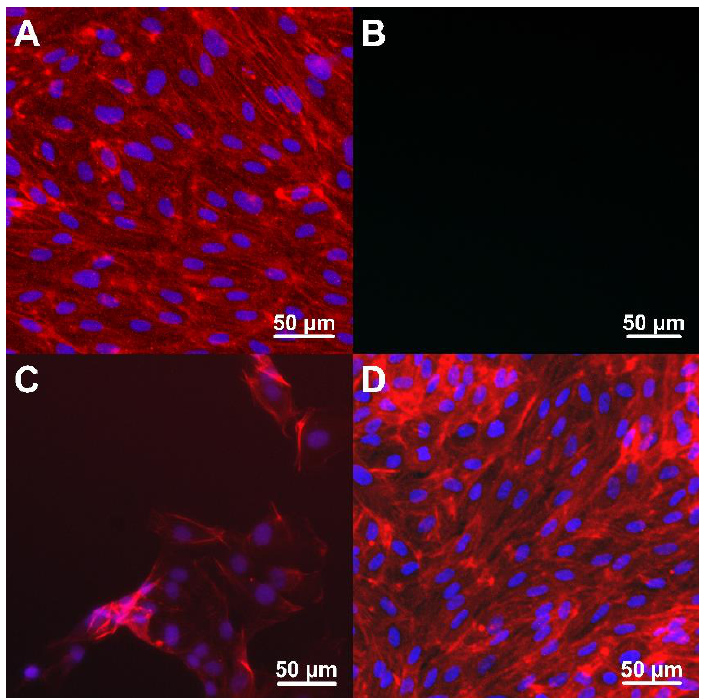
Figure 5. Relative number of HUVEC cells on tested surfaces determined from live/death assay. While the pristine poly(MeOEGMA- block -GMA-N 3 ) brushes completely canceled out the cell adhesion and viability, the brush with 1.2 × 10 3 nmol/cm 2 RGD showed similar number of adherent and viable cells as the reference glass surface. Significant differences between the number of cells were calculated by the student t-test (* p < 0.05).